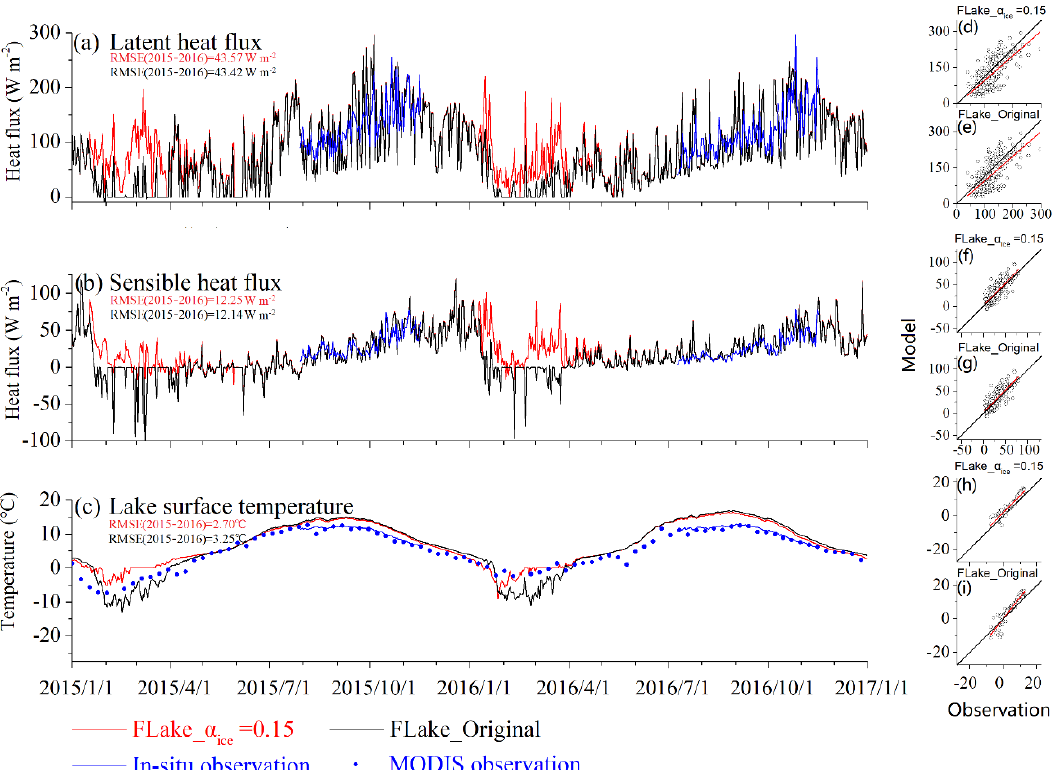
Figure 3. ( a – c ) Comparison and ( d – i ) evaluation of simulated LST, H and LE with in situ and MODIS observation data for Nam Co: ( a, d, e ) LE, ( b, f, g ) H, ( c, h, i ) LST. A fitted curve is shown for each variable, where the x represents the in situ observations and the y represents the simulated results. The comparison period is from January 2015 to December 2016.